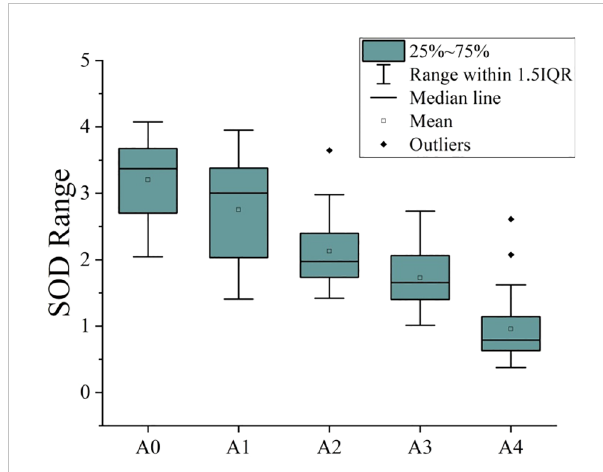
FIGURE 3 Boxplot of SOD values of peanuts with different aging